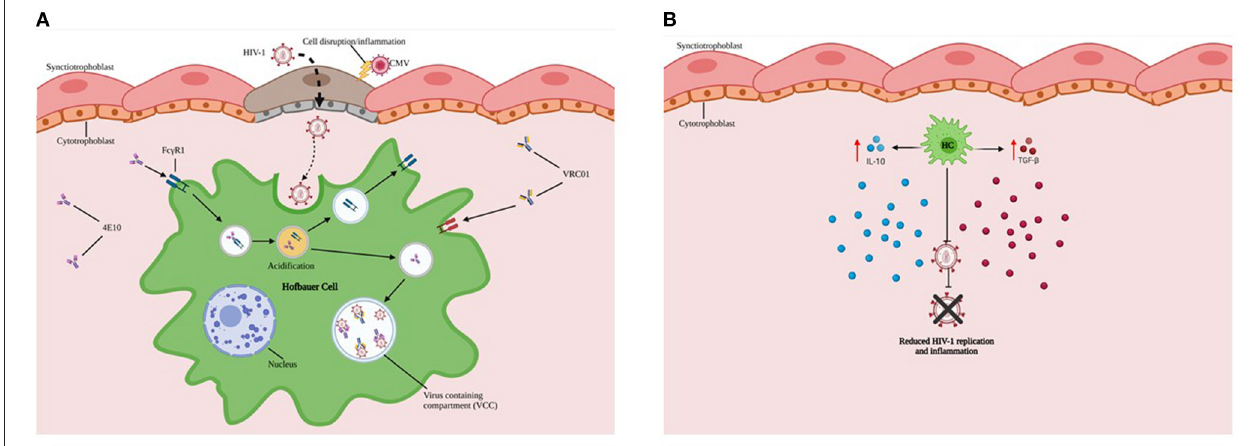
FIGURE 2 | HCs exhibit reduced ability to replicate HIV-1. (A) HCs (Green) sequester virus and may serve as protective reservoirs to permit intracellular neutralization in virus-containing compartments (VCCs in Blue). (B) Endogenous production and secretion of immunoregulatory cytokines such as IL-10 and TGF- β by HCs are important in not only supporting tolerance to the haploidentical fetus but also limiting inflammation and viral replication during maternal HIV-1